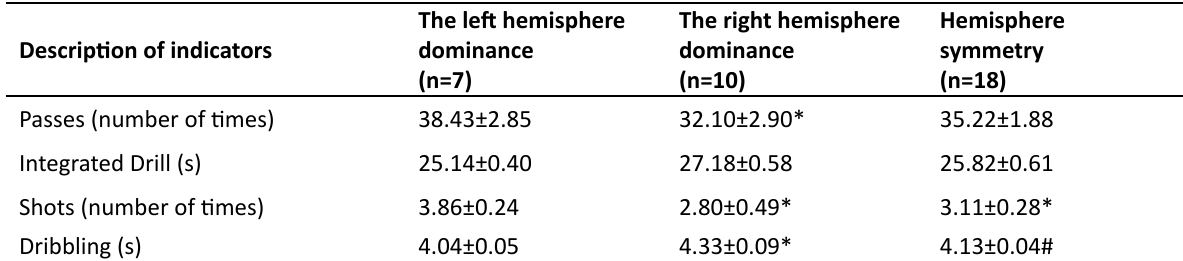
Table 1. Indicators of technical readiness of basketball players aged 12-13 with different cerebral asymmetry profile while exercising with the dominant hand